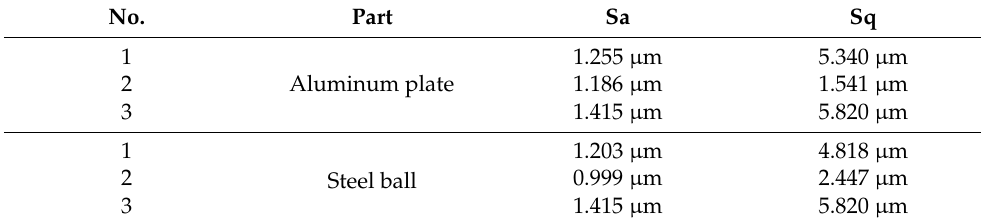
Figure 16. Experimental measurement of the radius of the ball. Table 1. Surface roughness parameters of the contact surfaces.